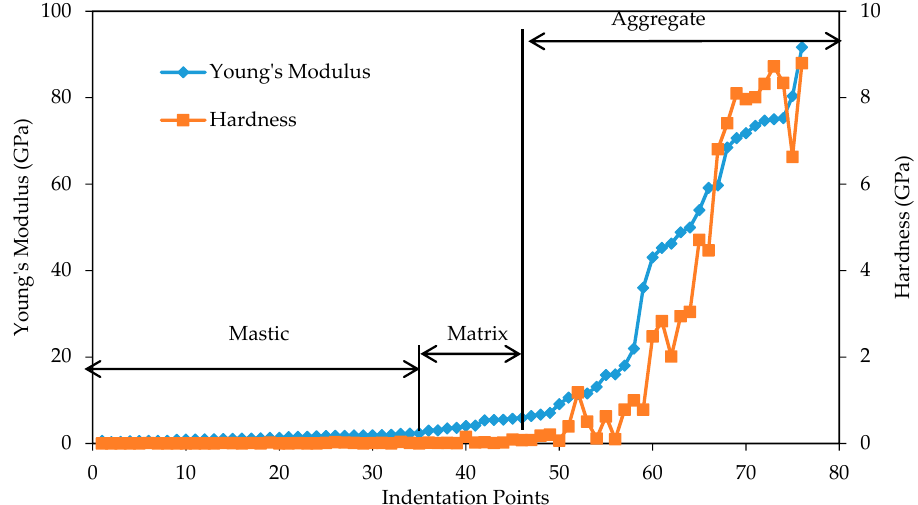
Figure 11. Young’s modulus and hardness of all phases in sample without hydrated lime.